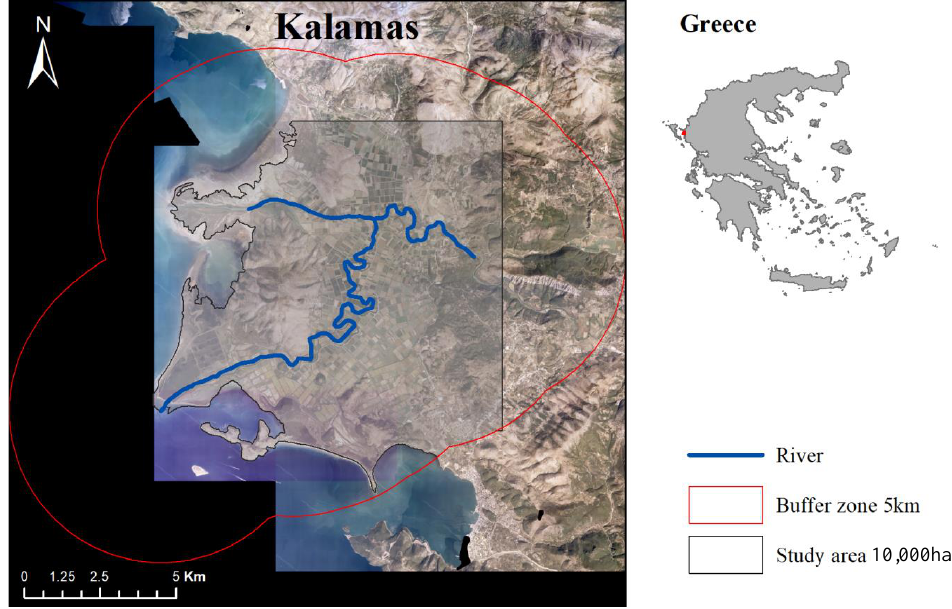
Figure 2. Schematic representation of the rules applied to define landscape extent.